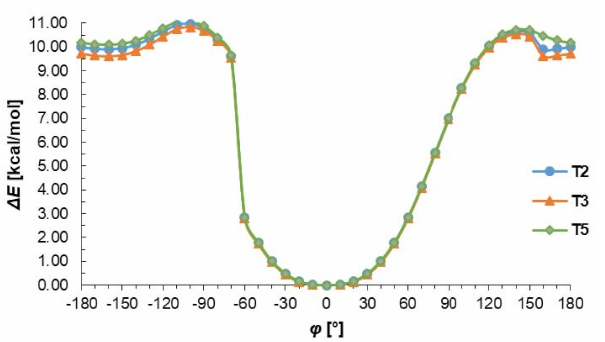
Figure 3. The energy effect of the free rotation for the torsion angle ϕ = N1–C2–N4–N5 calculated for T2 , T3 , and T5 using the semiempirical AM1